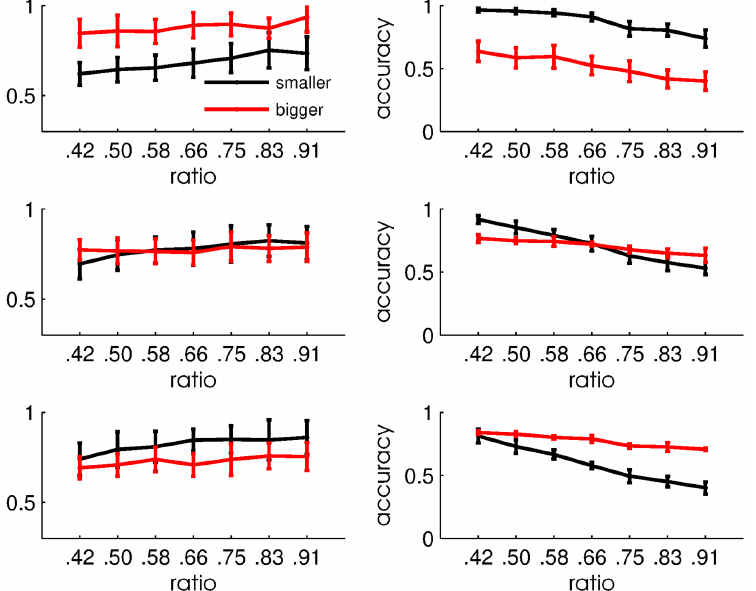
Figure 4. Mean correct RTs, and accuracy levels averaged across subjects for small standard conditions (first row), medium standard conditions (second row) and big standard conditions (third row). Error bars represents standard errors of the mean. The legend shows whether the target stimulus was smaller or bigger than the standard